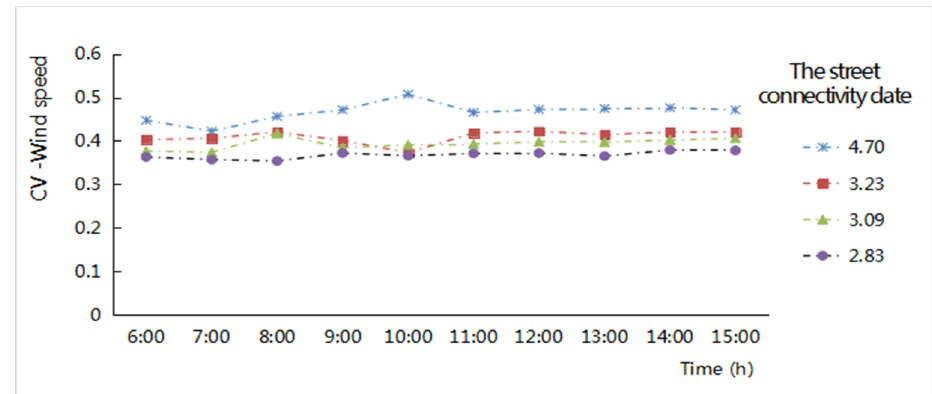
Figure 10. Hourly CV values variation of the wind speed related to different levels of street connectivity of the street network from 6:00 to 15:00 in the four study areas.